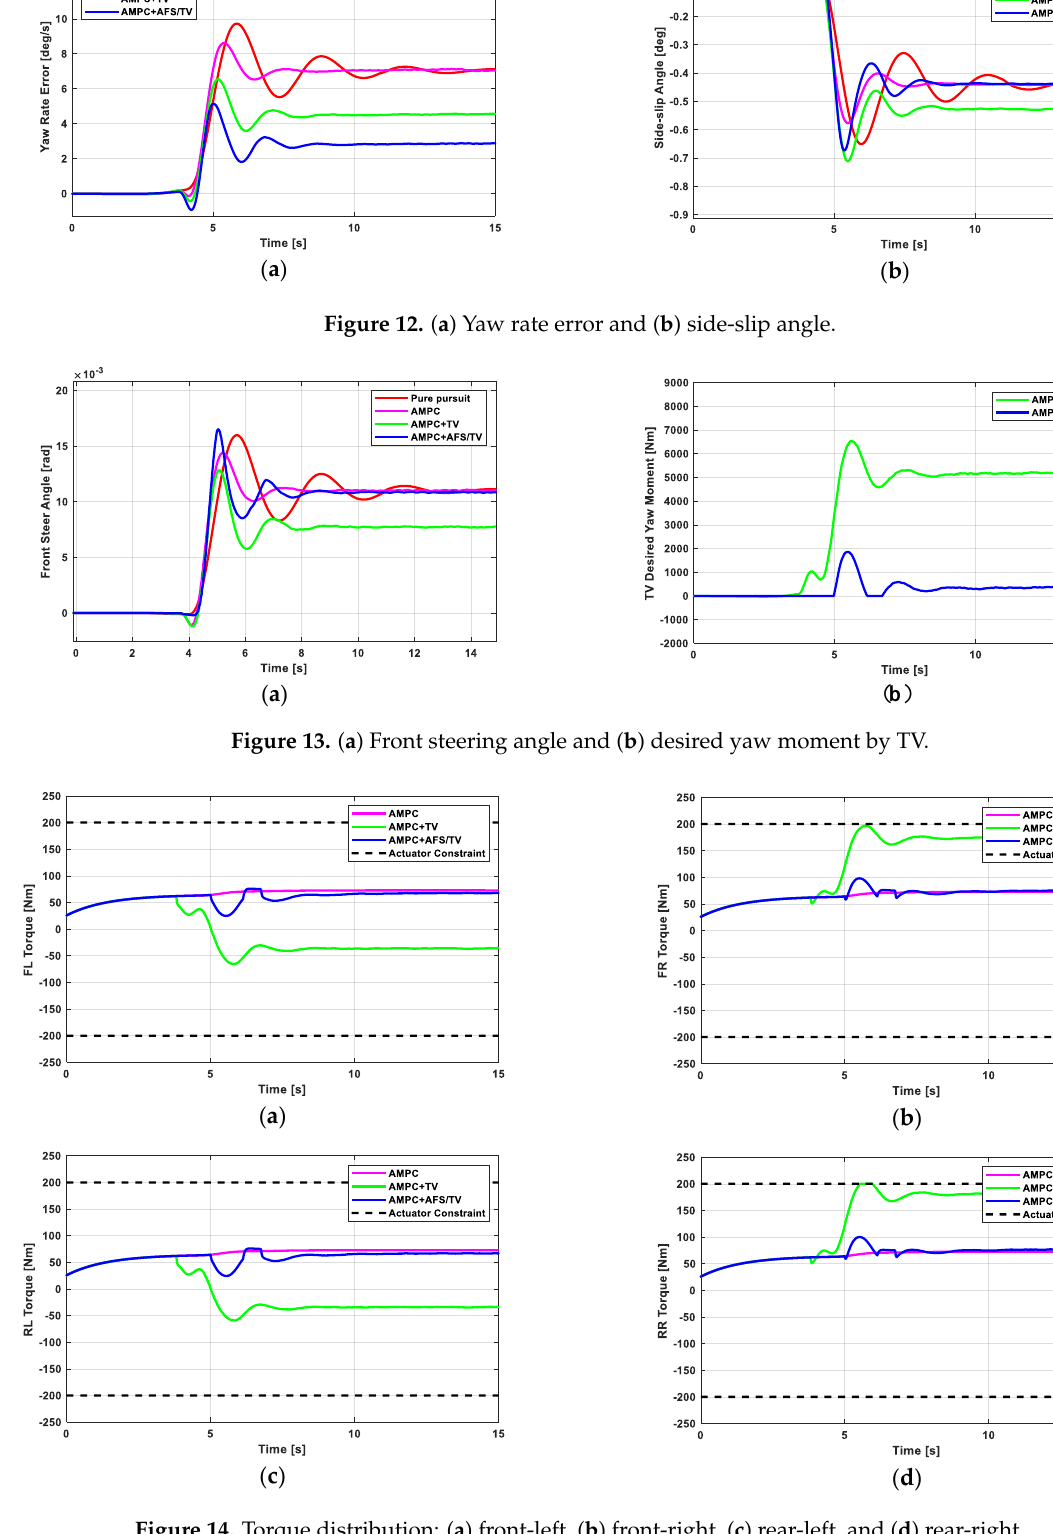
( d ) Figure 14. Torque distribution: ( a ) front-left, ( b ) front-right, ( c ) rear-left, and ( d ) rear-right. 5.3. Scenario 3: Single Lane Change (for Stability Analysis) Phase plane analysis is a method of confirming system characteristics or stability. The phase plane of a side-slip angle can predict lateral vehicle stability [35–37]. A single lane change was performed at speeds of 100 kph, 130 kph, and 160 kph to verify the stability of the closed-loop system of AMPC + AFS/TV. Since Scenario 1 and Scenario 2 demon-